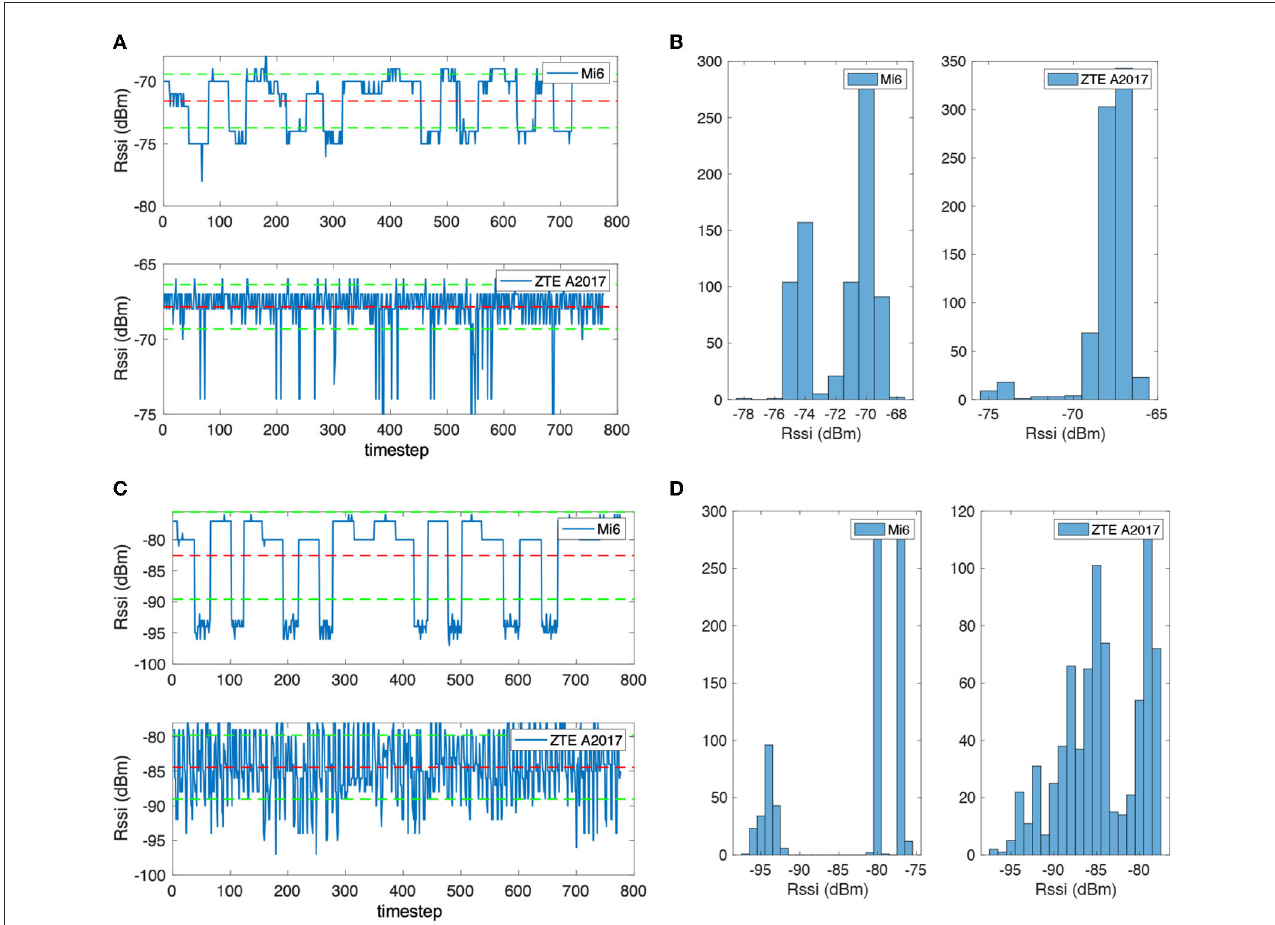
FIGURE4 (A) The received signal strength sequence of a Bluetooth beacon with 0.6m distance. (B) The received signal strength sequence of a Bluetooth beacon with 1.5m distance. (C) The received signal strength distribution of a Bluetooth beacon with 0.6m distance. (D) The received signal strength distribution of a Bluetooth beacon with 1.5m